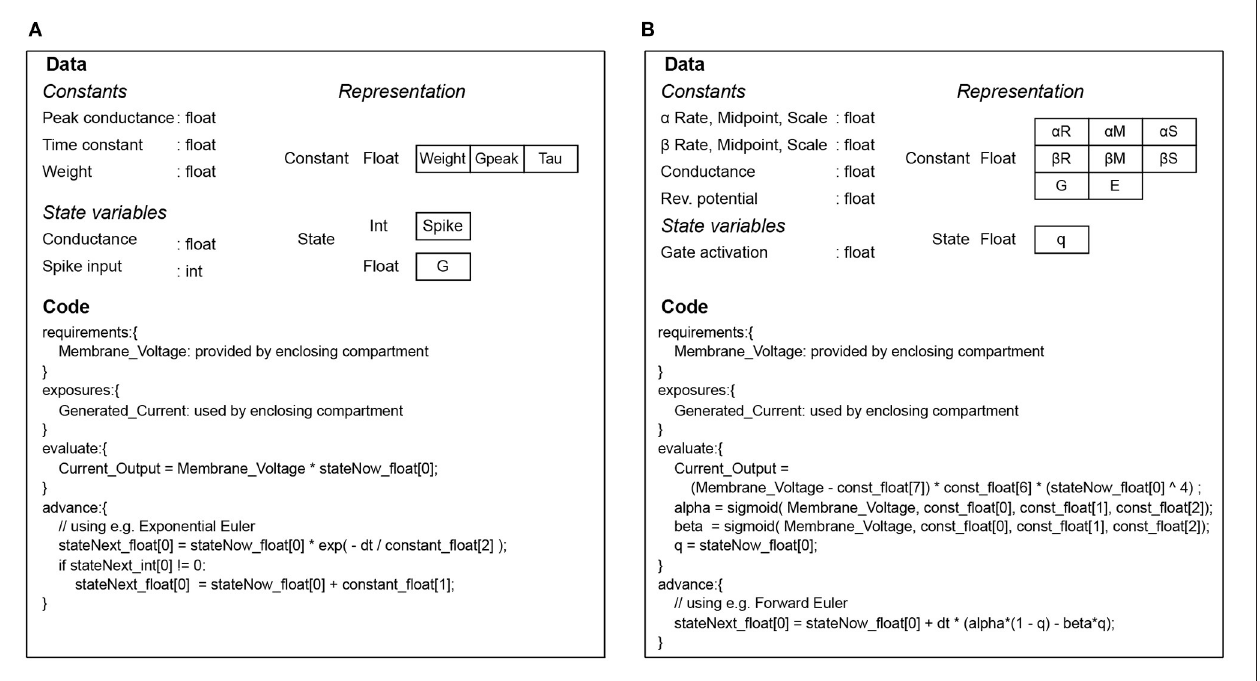
FIGURE 3 | Code and data signatures for an exponential-conductance post-synaptic component (A) , and for a classic Hodgkin-Huxley sodium channel (B)